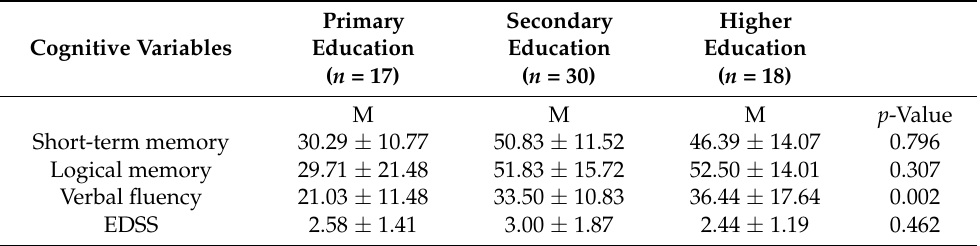
Table 3. Relationships between cognitive variables and educational level in the multiple sclero- sis sample.